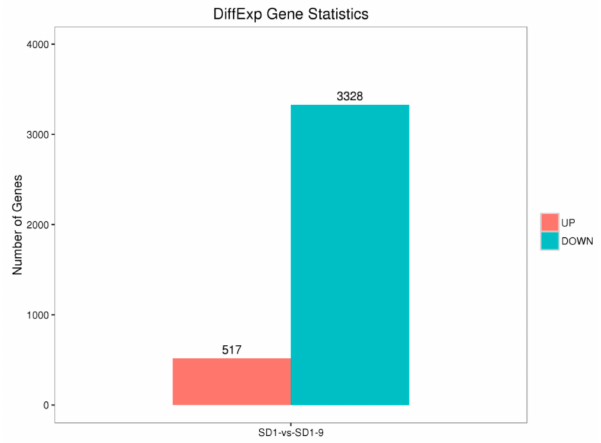
Figure 5. Number of di ff erentially expressed genes of P. capsici .